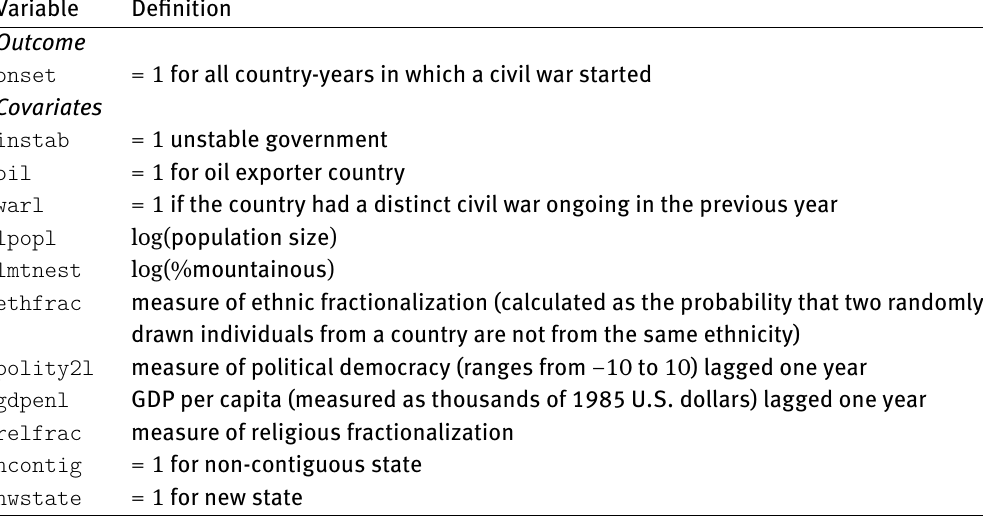
Table 3: Civil war data: description of the outcome variable and covariates.